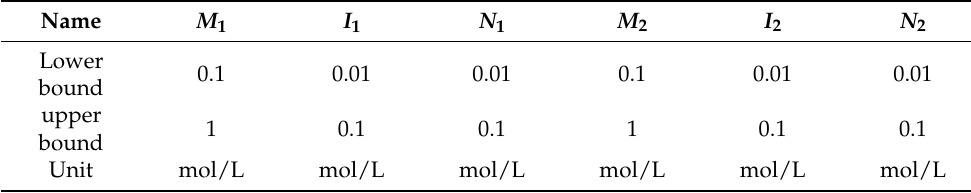
Table 3. Boundaries of decision variables.